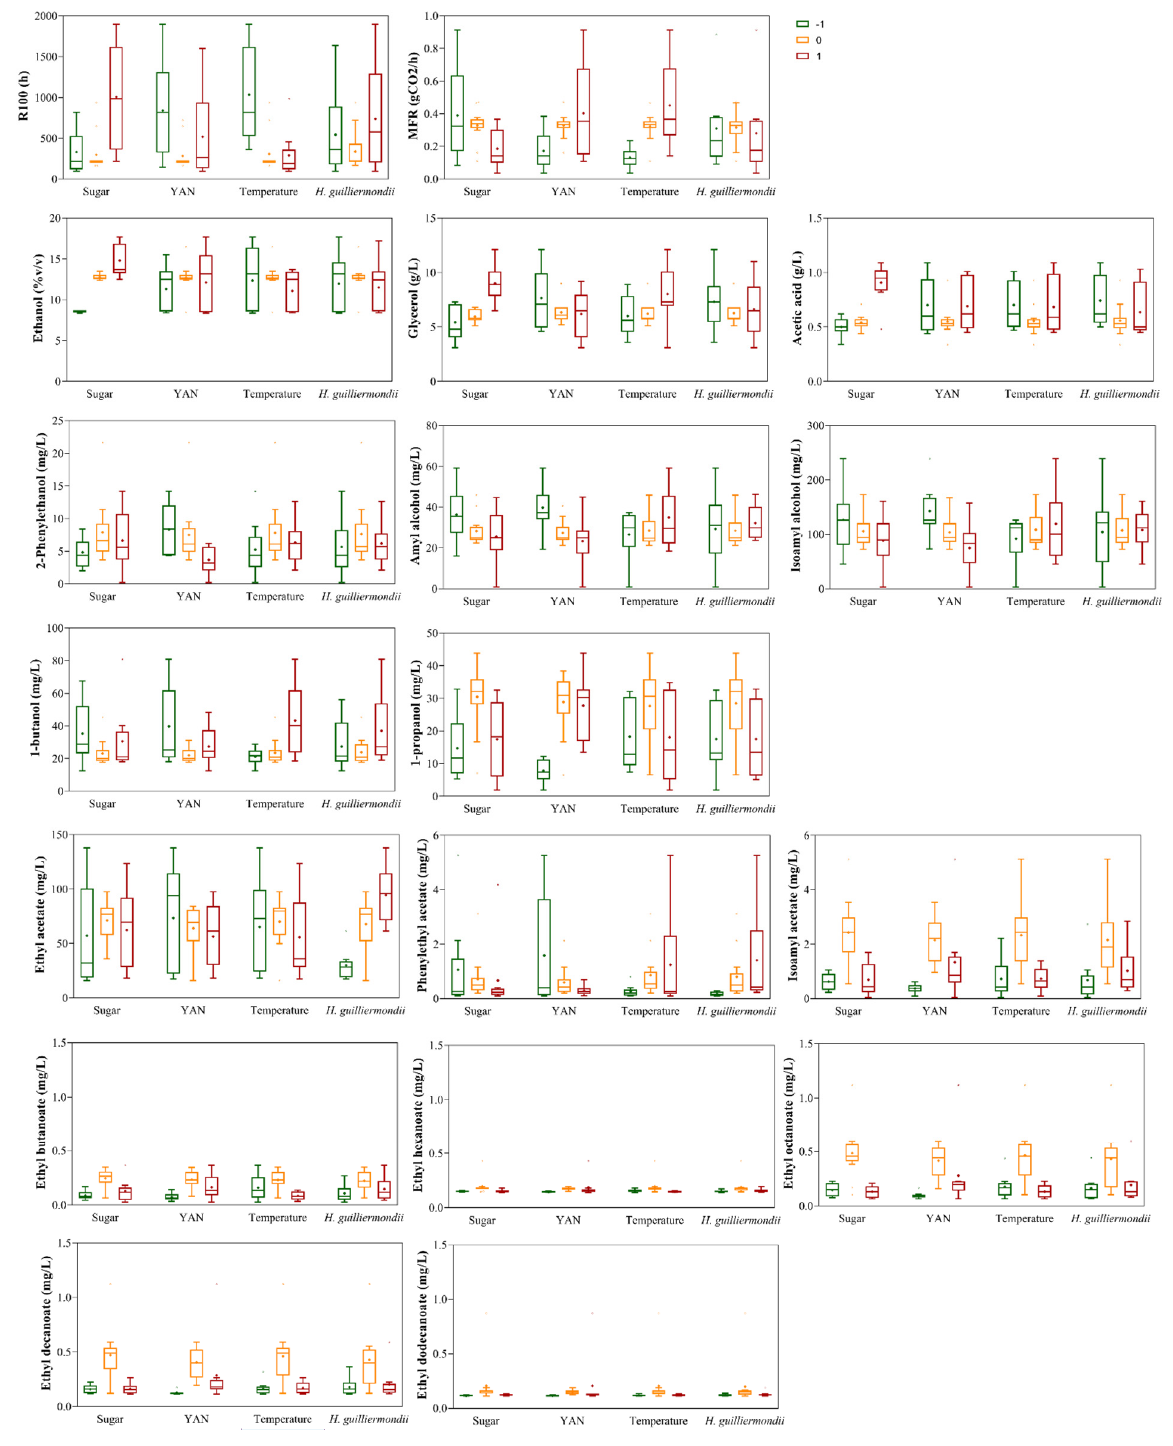
Figure 1. Boxplots exploring the relationships between the 18 responses and each level (-1, 0 and +1) of the factors tested: Sugar, YAN, Temperature, and H. guilliermondii UTAD222 inoculum. -1: 150 g/L Sugars, 100 mg/L YAN, 10 °C, 0 cells/mL H. guilliermondii ; 0: 225 g/L Sugars, 300 mg/L YAN, 20 °C, 5 × 10 5 cells/mL H. guilliermondii ; 1: 300 g/L Sugars, 500 mg/L YAN, 30 °C, 1 × 10 6 cells/mL H. guilliermondii . Boxplots indicate, for each response, the values by each factor and corresponding level, showing the mean values (plus symbol) and upper and lower quartiles, with vertical bars showing the minimum and maximum value, respectively.